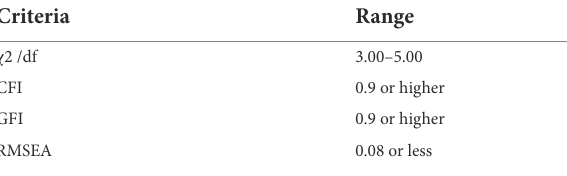
TABLE 4 Acceptable overall fit of each model was evaluated using the following indices.